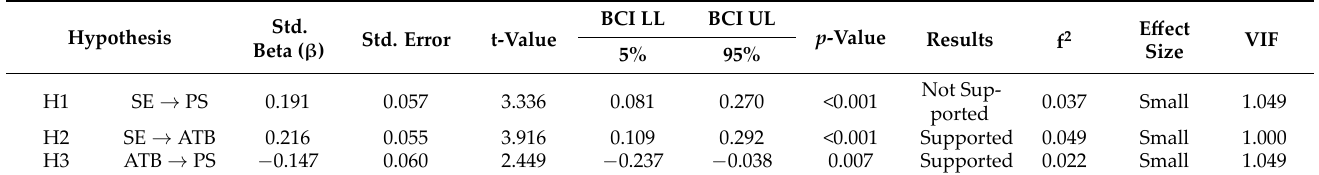
Table 5. Hypothesis Testing.